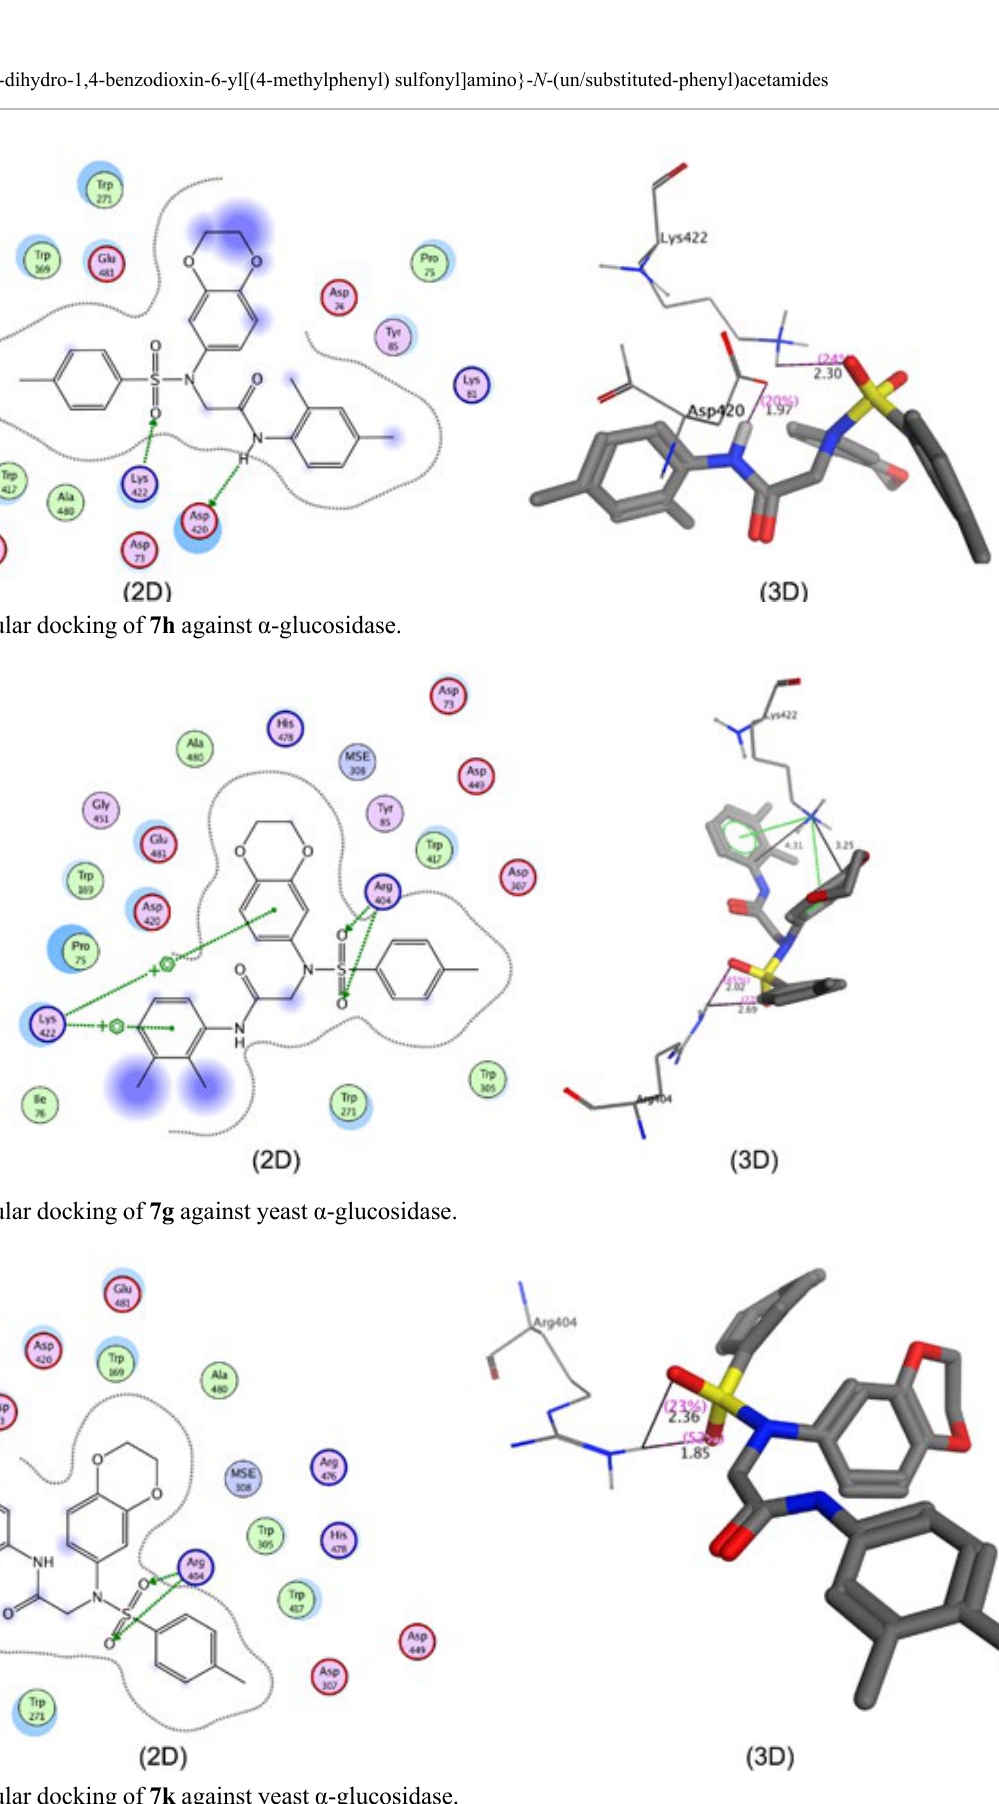
FIGURE 3 - Molecular docking of 7k against yeast Braz. J. Pharm. Sci. 2019;55:e17032